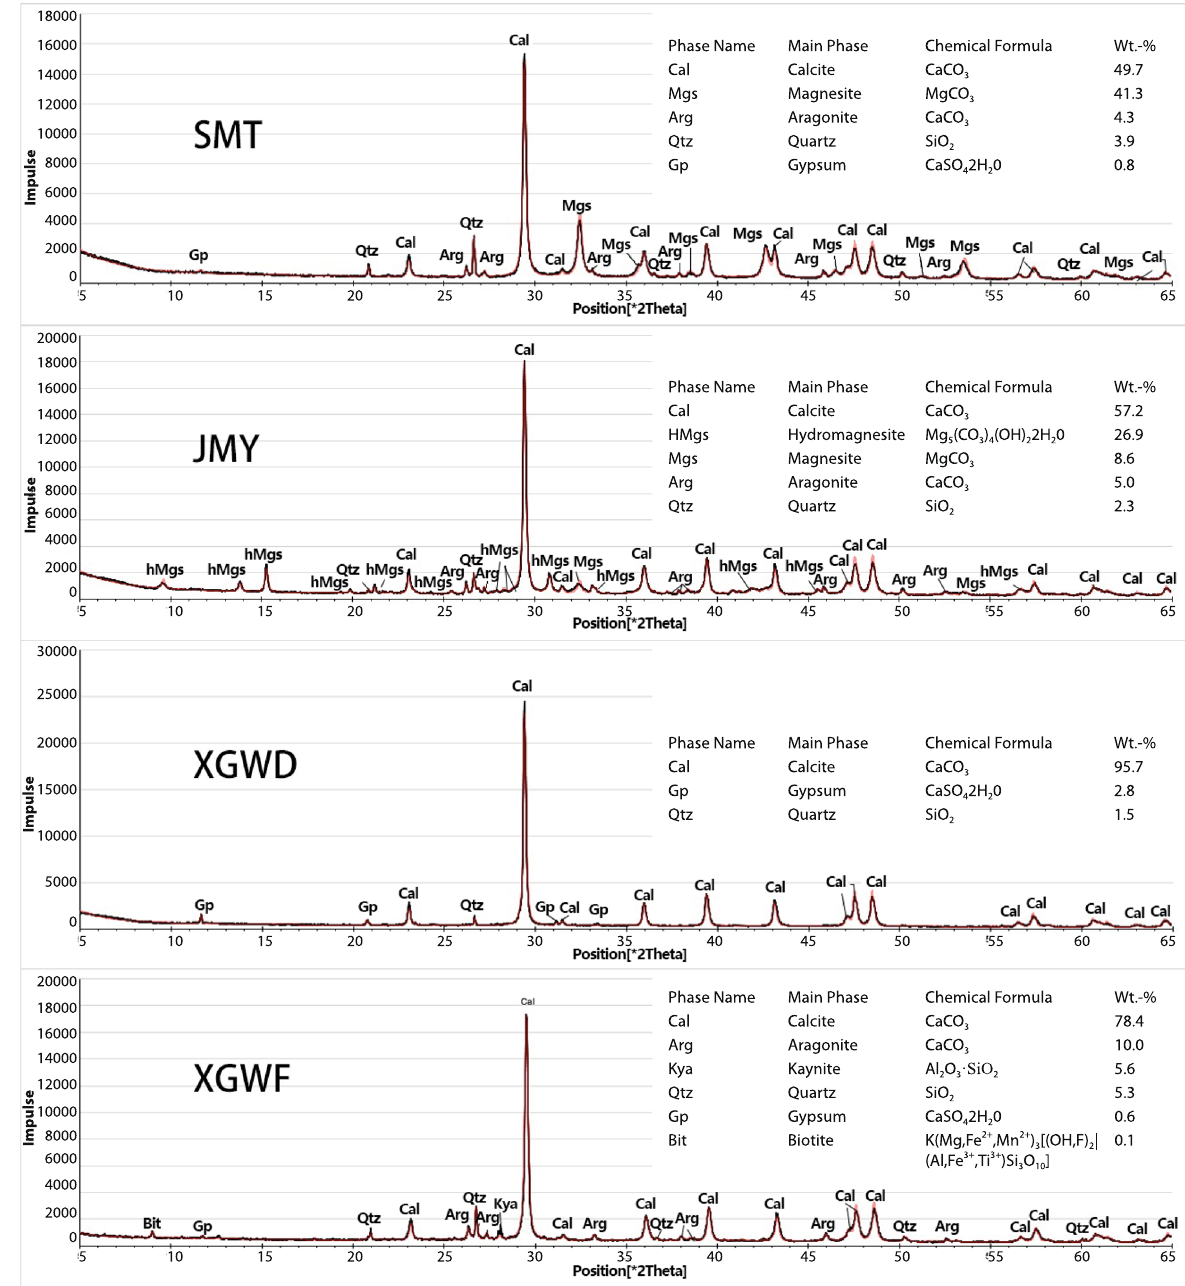
Fig. 17 Diffractograms of the mortar samples JMY (bedding mortar), SMT (bedding mortar), XGWD (bedding mortar), and XGWF (pointing mortar) (Source: Tanja Dettmering and Bernhard